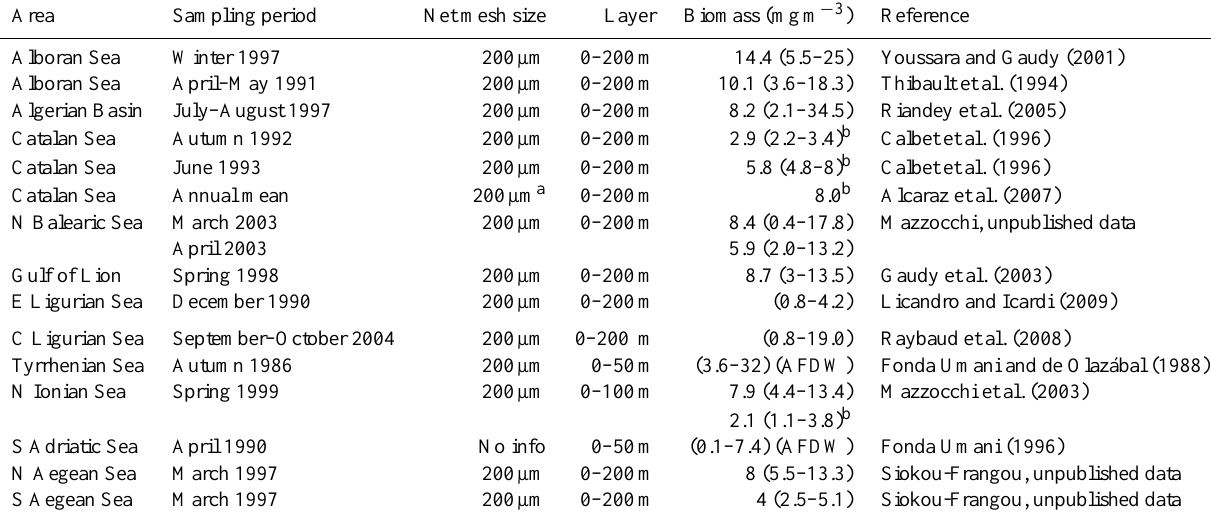
Table 6. Mean values (range) of mesozooplankton biomass (as dry mass or organic C) in different areas of the Mediterranean Sea.